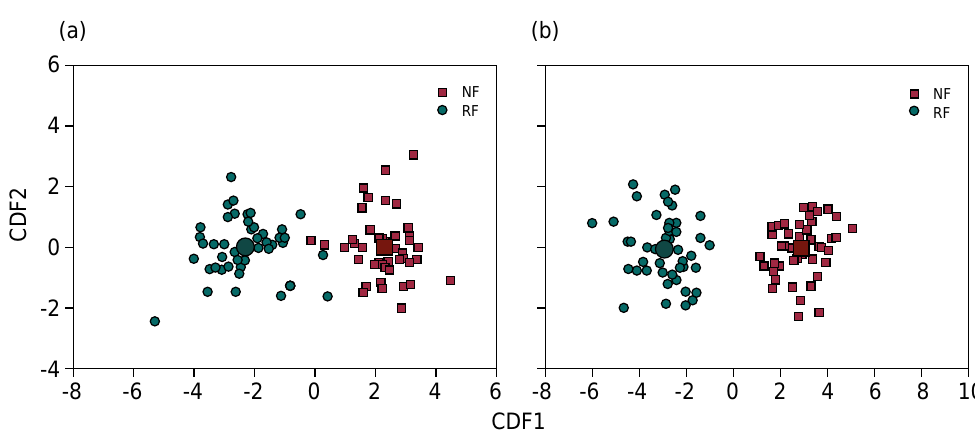
Figure 2. Standardized Canonical Coefficients (SCC) of the Canonical Discriminant functions 1 (CDF1) and 2 (CDF2), discriminating native Araucaria forests from reforested ones, when considering properties of environmental variables and of soil macrofauna sampled according to the TSBF methodology, in winter (a) and summer (b). The central black symbols represent the average of SCC for each